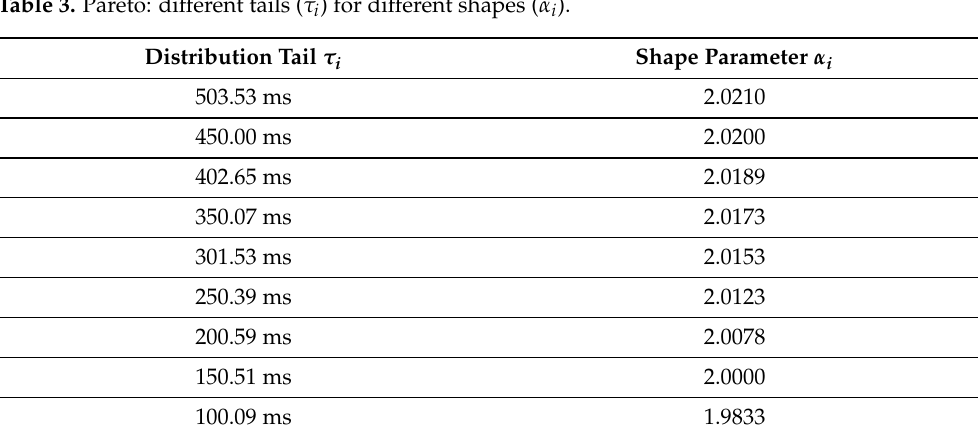
Table 3. Pareto: different tails ( τ i ) for different shapes ( α i